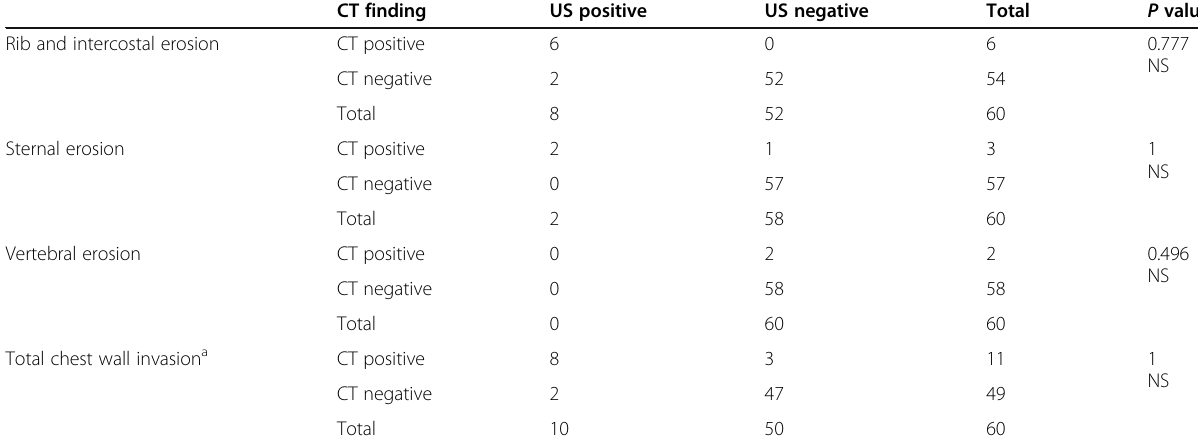
Table 8 Assessment of chest wall by US in comparison to CT